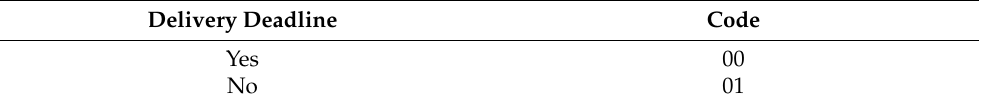
Table 4. Time-limit